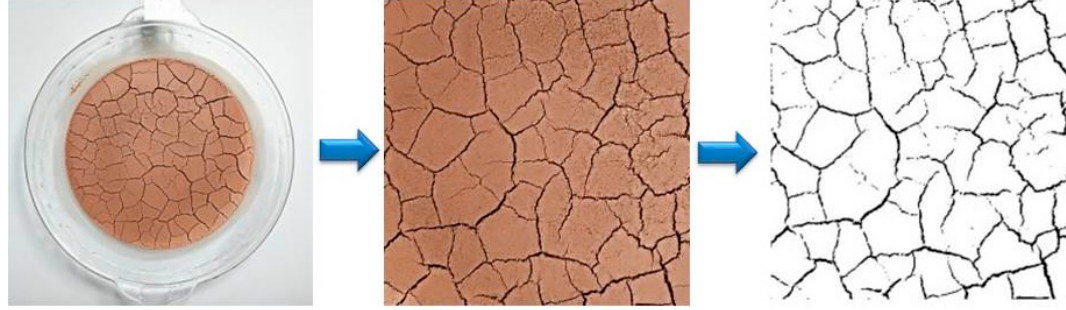
Figure 2. Image processing process.